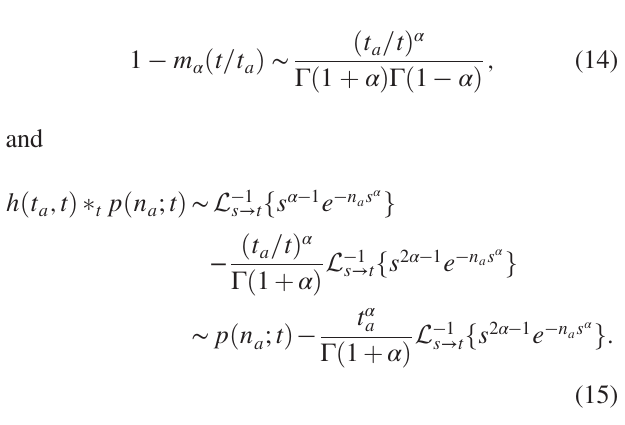
FIG. 2 (color online). Scaling convergence of the aging renewal process. We simulate a renewal process with a waiting time distribution ψ ð t Þ ¼ ð 4 π Þ − 1 = 2 ð π − 1 þ t Þ − 3 = 2 . The latter is of the heavy-tailed form (1) with α ¼ 0 . 5 , τ ¼ 1 (a.u.). Time is rescaled as ↦ n ; t t ↦ t=c and renewals as n =c α . We plot the PDF p n ; t Þ for the number of renewals within the time interval ½ t a a a ð a a 100 and t ¼ 1 , in terms of the rescaled quantities. The area below each step in the graph represents the probability to count a with t a ¼ certain number of (rescaled) renewals; the respective values are indicated by symbols. As the scaling constant c increases (see key), p converges to the analytical, smooth scaling limit, i.e., the PDF given through Eqs. (11 – 13) (same as in Fig. 4, right center panel). Since > 0 , the total area below each graph equals the probability m α to count any events at all. here we only show renewal probabilities for n a Ensemble statistics are based on data from 10 7 independent renewal process